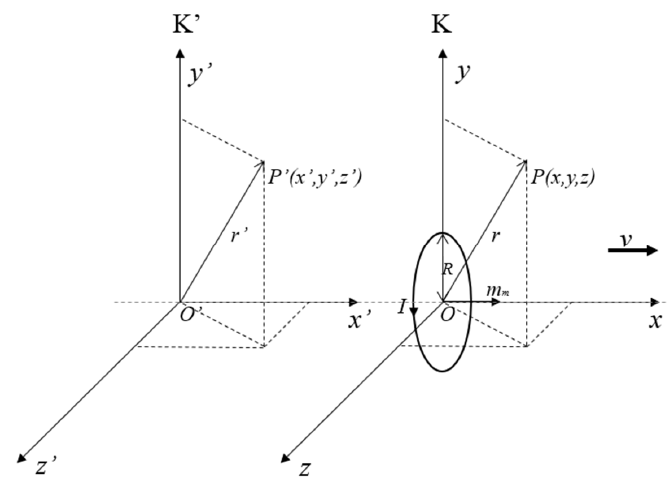
Figure 2. Coordinate model of moving magnetic dipole.